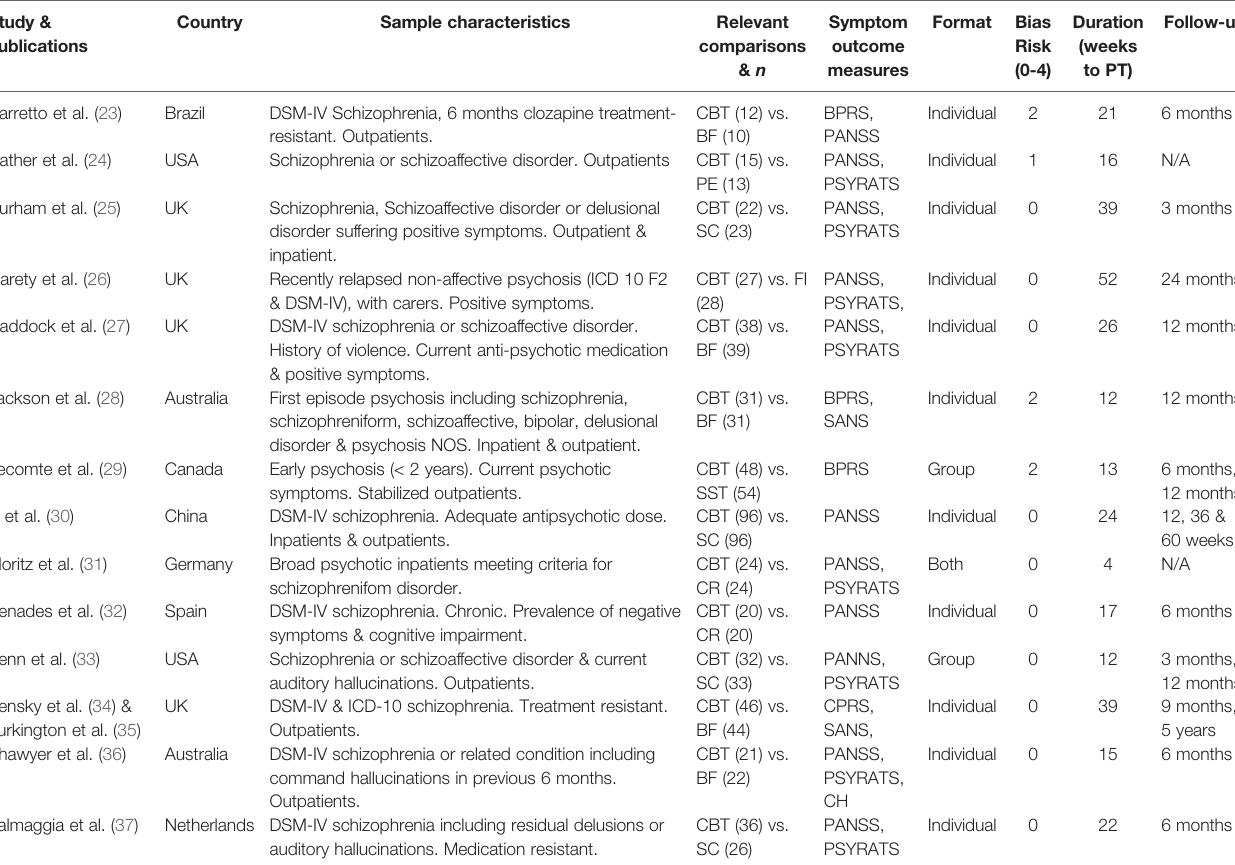
TABLE 1 | Selected characteristics of randomised controlled trials of CBTp versus other psychological interventions for